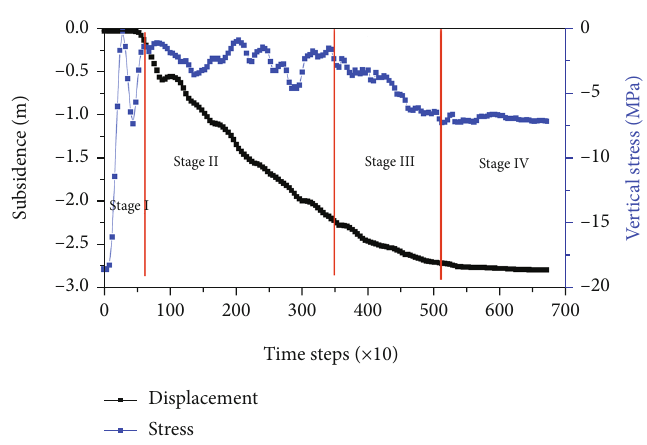
Figure 15: Stress evolution of bedrock and subsidence of monitoring point in numerical